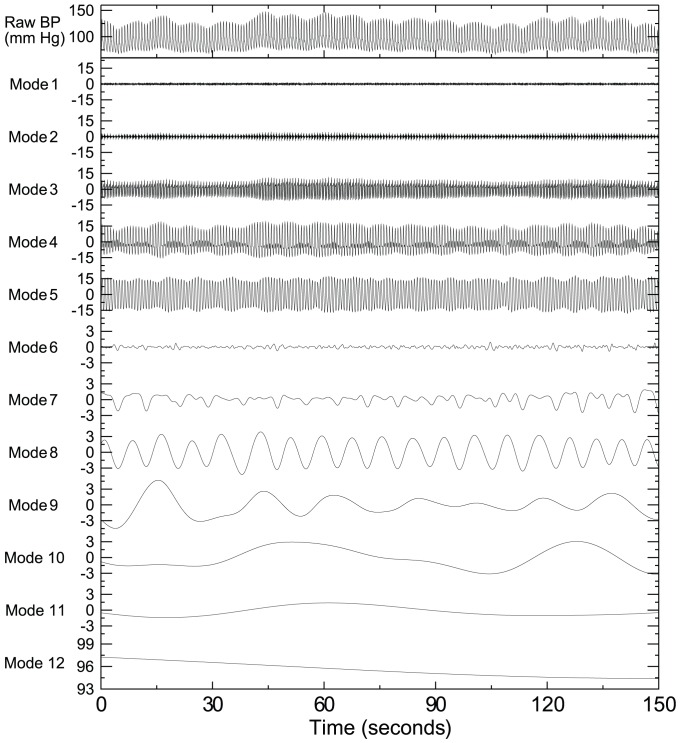
Demonstration of empirical mode decomposition.A blood pressure (BP) recording was collected from finger plethysmography in a non-stroke subject during supine rest condition (Top panel). Decomposed oscillatory components of the signal are shown in the followed panels. Each component consists of oscillations within a narrow frequency band. Note that the amplitude and period of oscillations in each component were not constant, indicating nonstationarity in the BP signal.